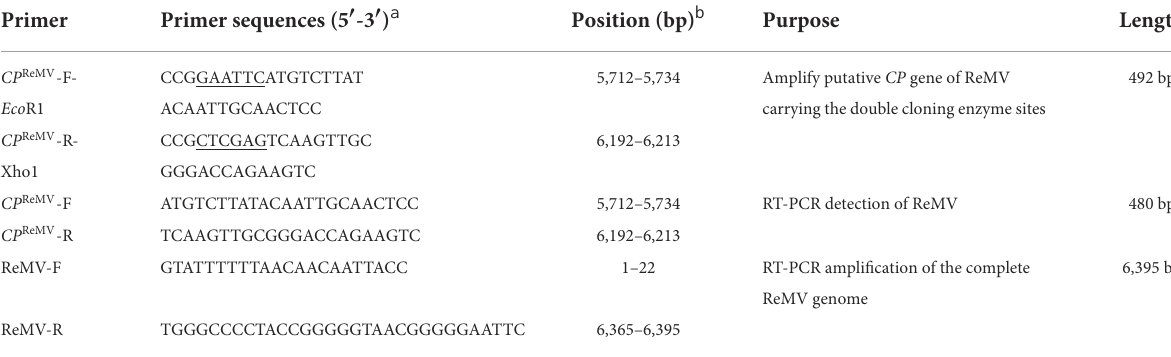
TABLE 1 Primers used for ReMV CP gene cloning and virus detection by RT-PCR.